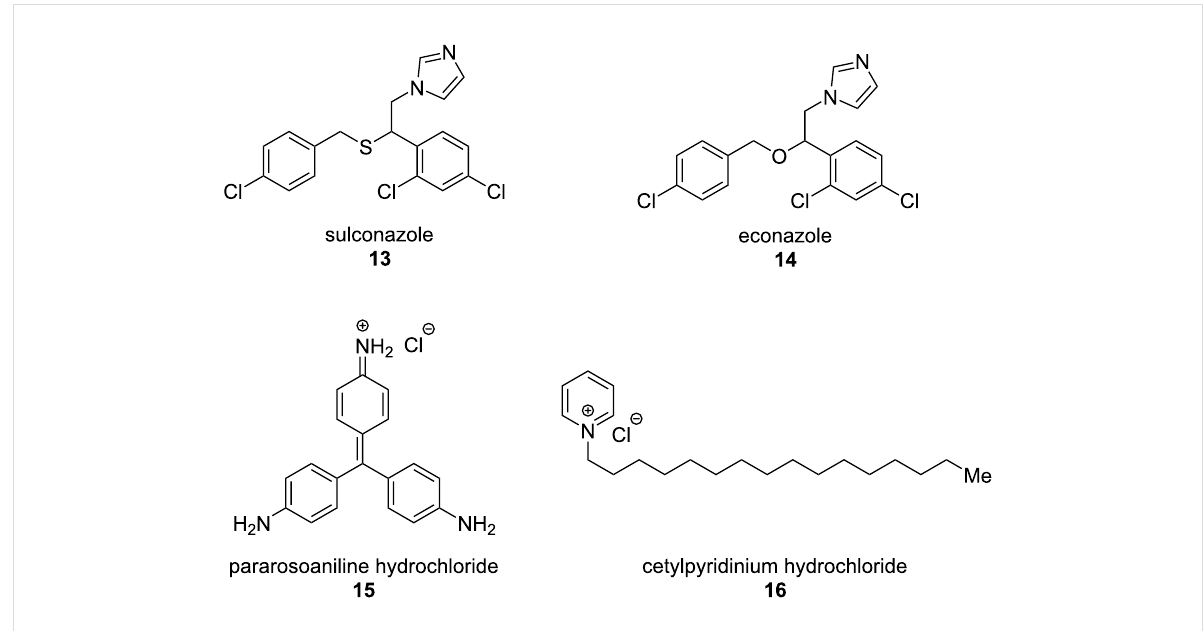
Figure 3: Compounds with anthelmintic activity identified by a combination of screening against Ancylostoma ceylanicum, C. elegans, and T. muris